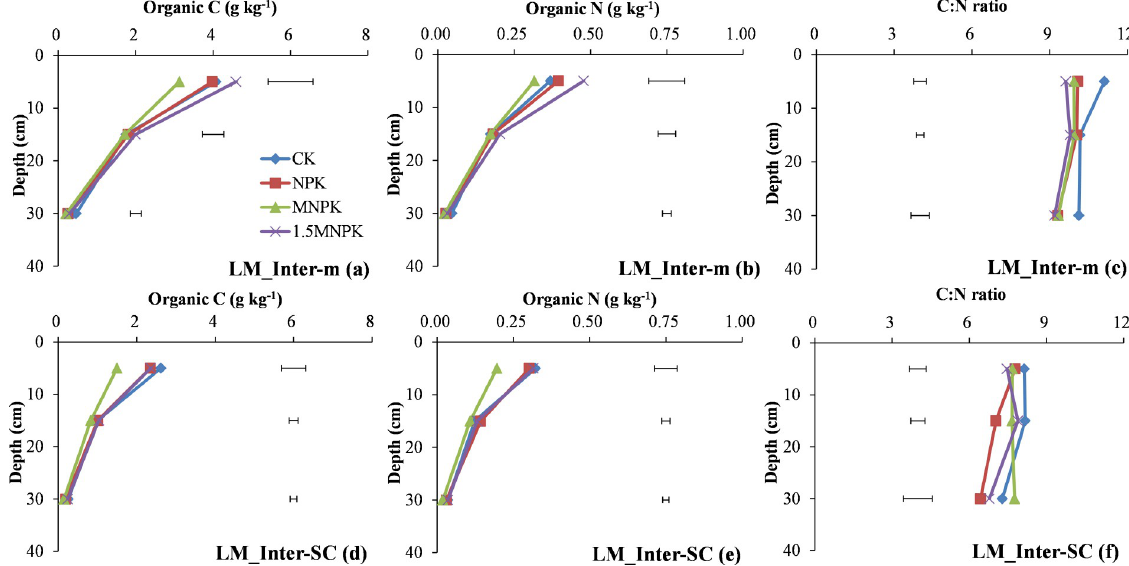
Fig 3. Change in organic C and N concentrations and their C/N ratios in large macroaggregate (LM) fractions of control (CK), chemical fertilizer (NPK), and the combined manure and chemical fertilizer (MNPK, 1.5MNPK) treatments in the top 40 cm of the soil profile. Values at each soil depth are the mean of three replicates. The horizontal lines denote the least significant difference values at the 0.05 level (LSD0.05) among different treatments at each soil depth. Symbols of aggregate fractions: see Fig 1